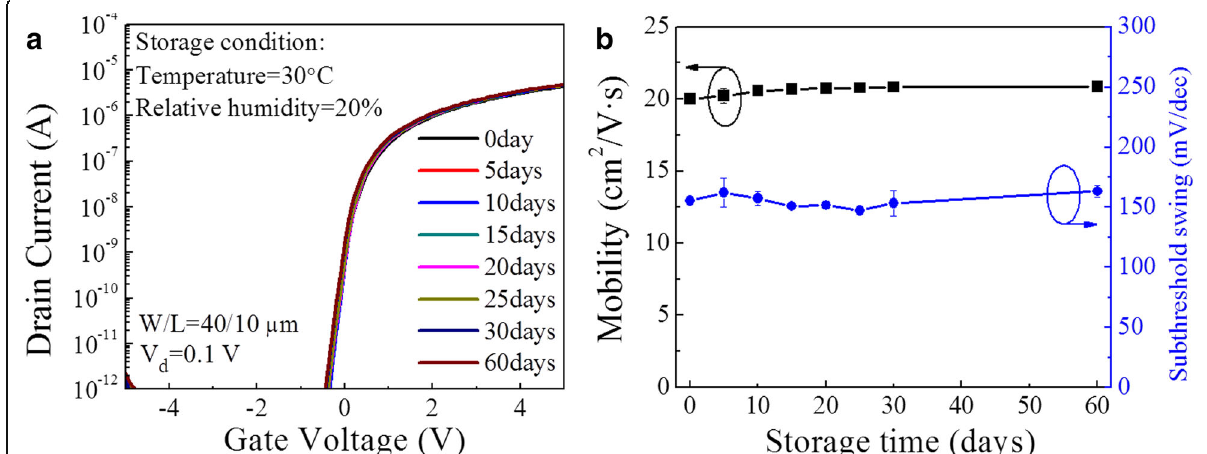
Fig. 4 Time-dependent stability of RT Al 2 O 3 TFT after being kept in a cabinet (20% RH) at 30°C. a Transfer curves. b Mobility and subthreshold swing